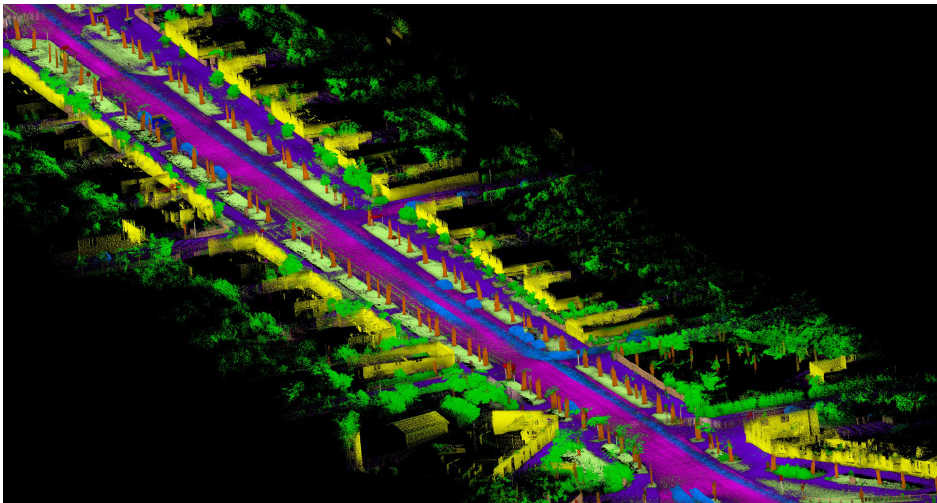
Figure 3. An illustration of point cloud data recorded with the ARVO system. This visualization uses semantic segmentation [60] and excludes the highest rings to make the road-level view and tree trunks (brown) more